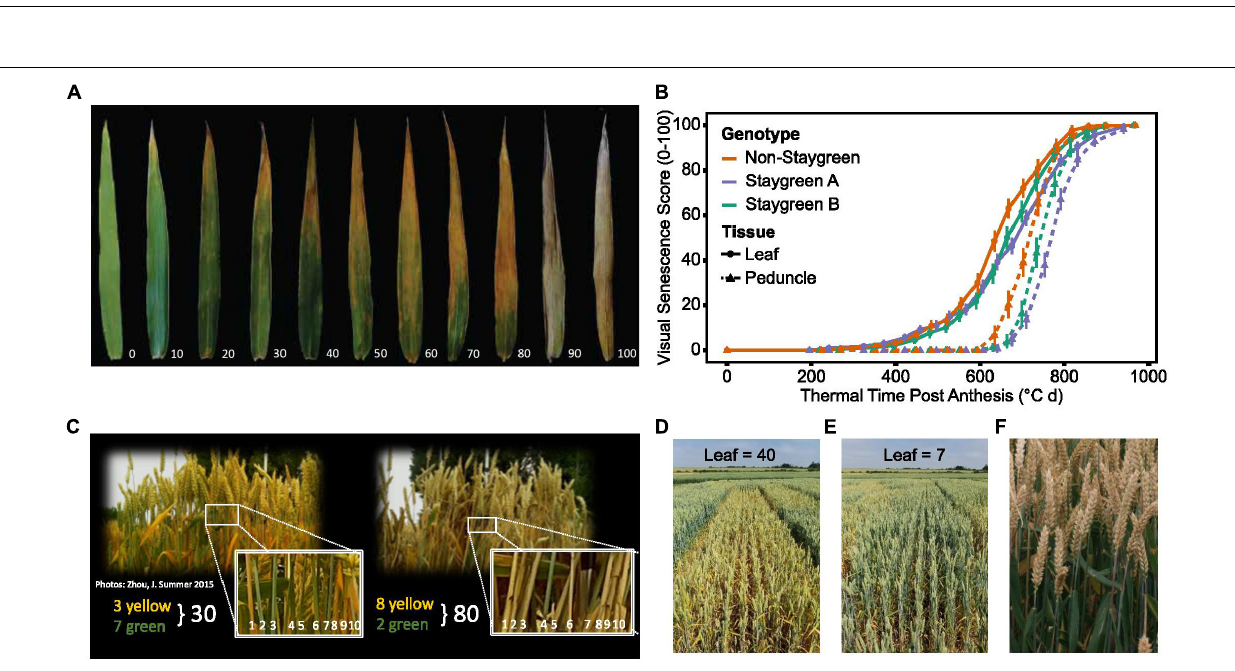
Frontiers in Plant Science |